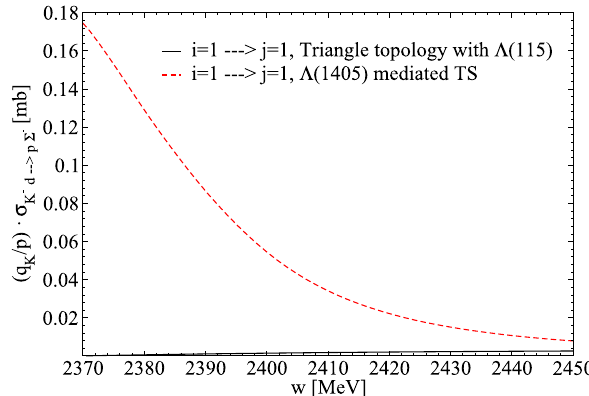
Fig. 14 Comparison between the contributions to the K − d → p Σ − total cross section from the mechanism depicted in Fig. 2b and the analogous one with Λ( 1115 ) in the triangle topology instead for the ↑↑→↑↑ spin transition. See more details in the text